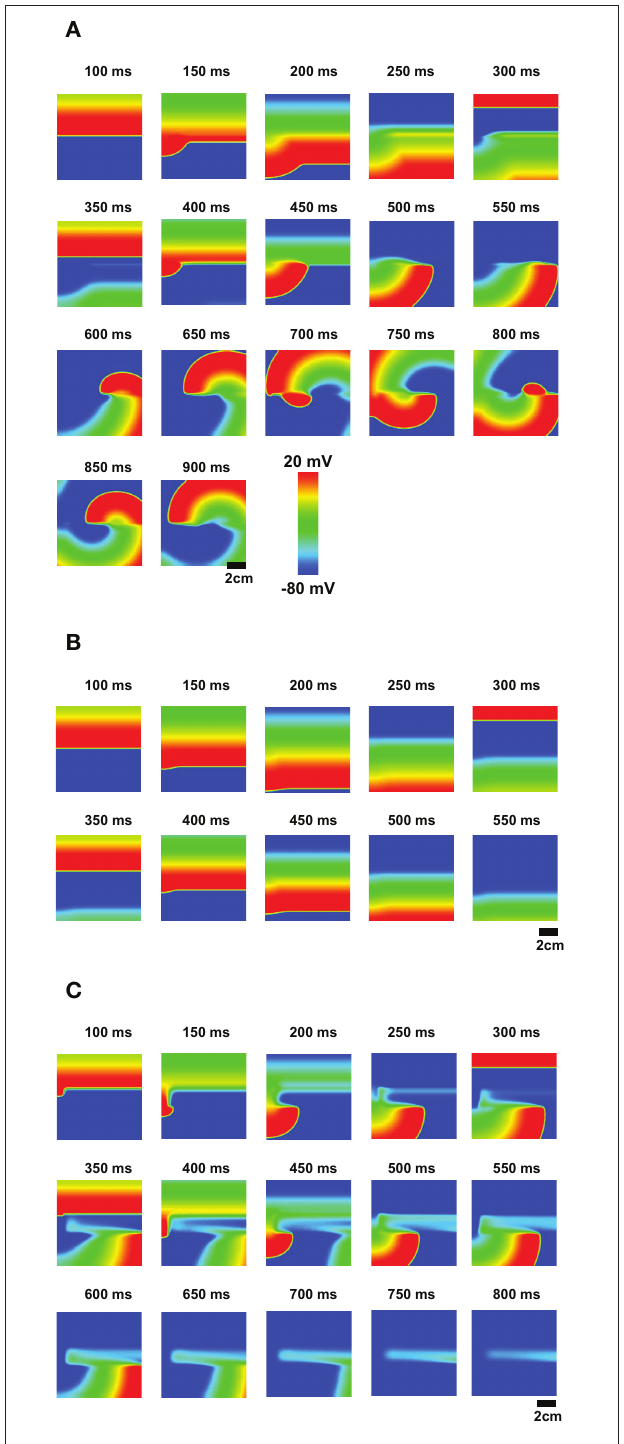
FIGURE 8 | EADs due to the non-excitable gap region cause reentry . (A) The optimal non-excitable gap region (1.2mm) cause EADs. These EADs block the next action potential wave and cause reentry. The tissue size is 9 ( Supplemental Movie 1 ; B) If the gap size is too small, EADs will not occur although there is a delay at the gap region. ( Supplemental Movie 2 ; C) If the gap size is too large, the action potential wave cannot propagate and the wave avoids this region ( Supplemental Movie 3